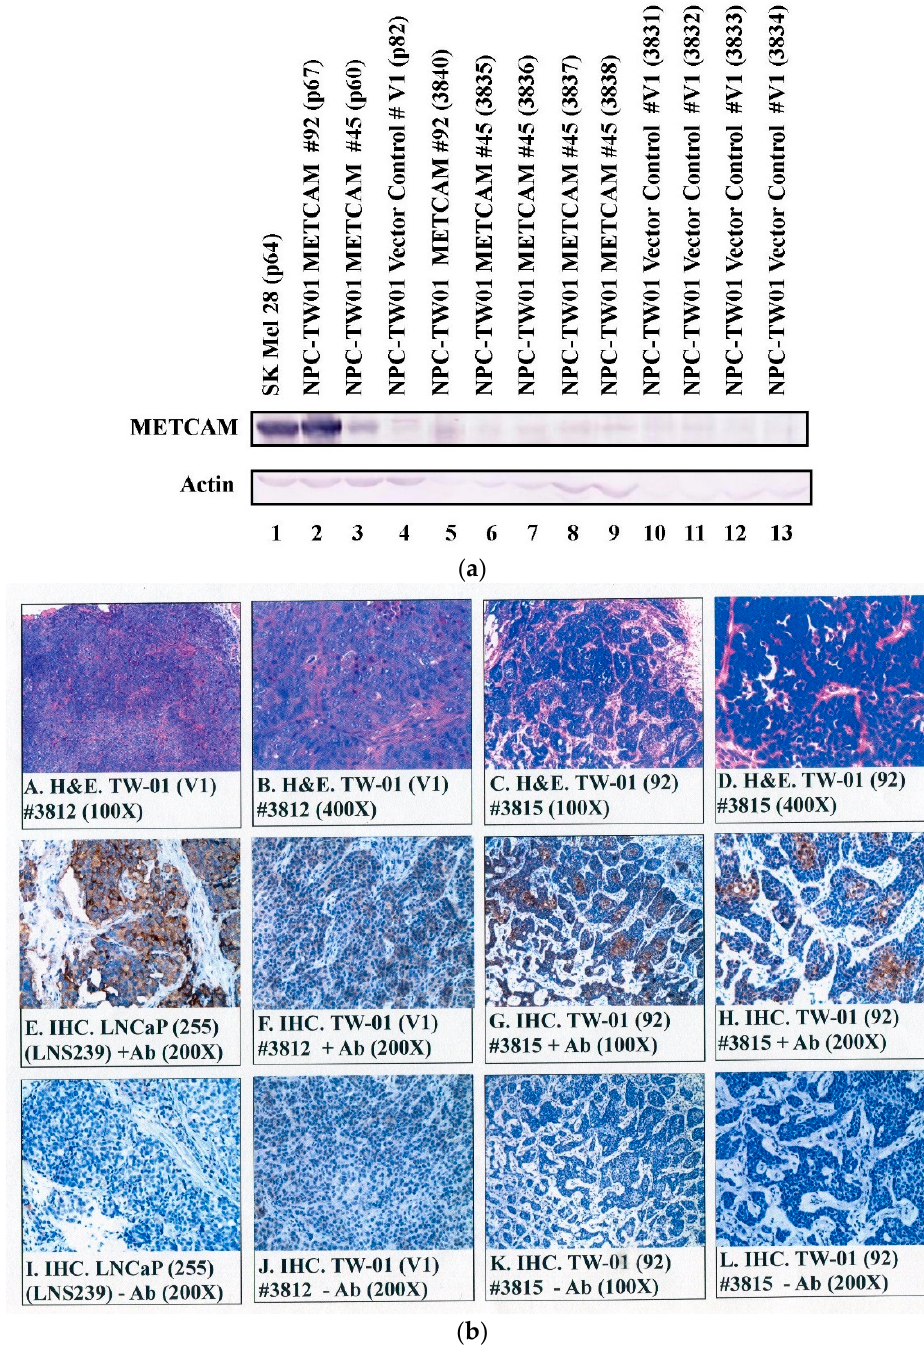
Figure 6. HuMETCAM/MUC18 antigen expression in tumor lysates and in tumor tissue sections. ( a ) The expression of huMETCAM/MUC18 in the lysates from the tumors was determined by Western blot analysis, as described in the Section 4. The expression of huMETCAM/MUC18 in the lysates from the tissue cultured the SK-Mel-28 cells (lane 1) and the NPC-TW01 clones #92 (lane 2), #45 (lane 3), and V1 (lane 4) were used as the controls. The huMETCAM/MUC18 expression levels in